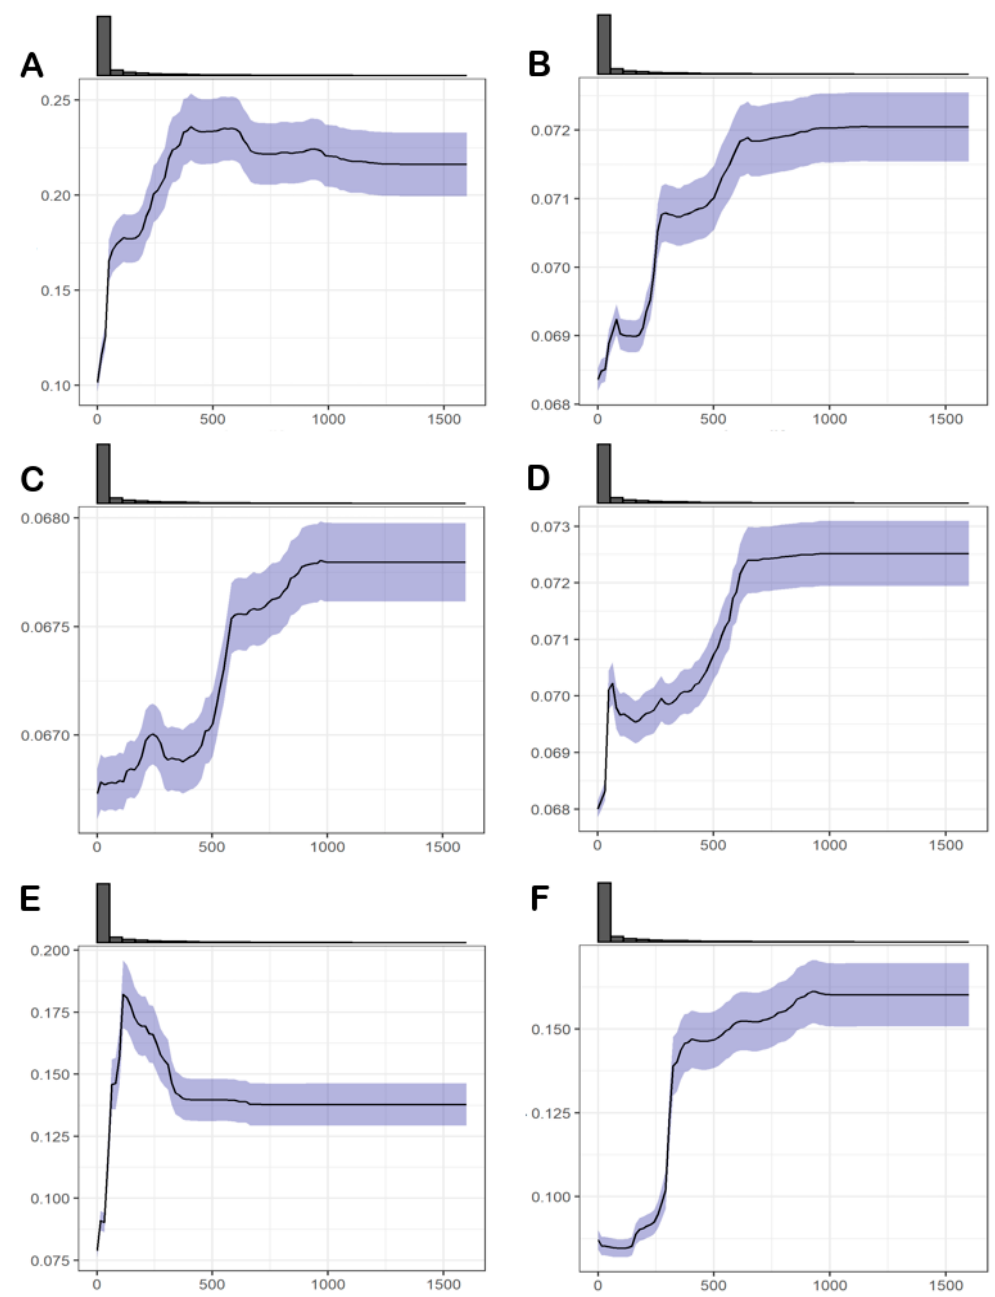
Figure A3. Response curves (average of all GBM models ± ½ std.-deviation) showing habitat suitability variation as function of broadleaf cover, for ( A ) MSD, ( B ) PRC, ( C ) T . lusitanica , ( D ) T . ebejeri , ( E ) T . semiaptera and ( F ) T . iberica .